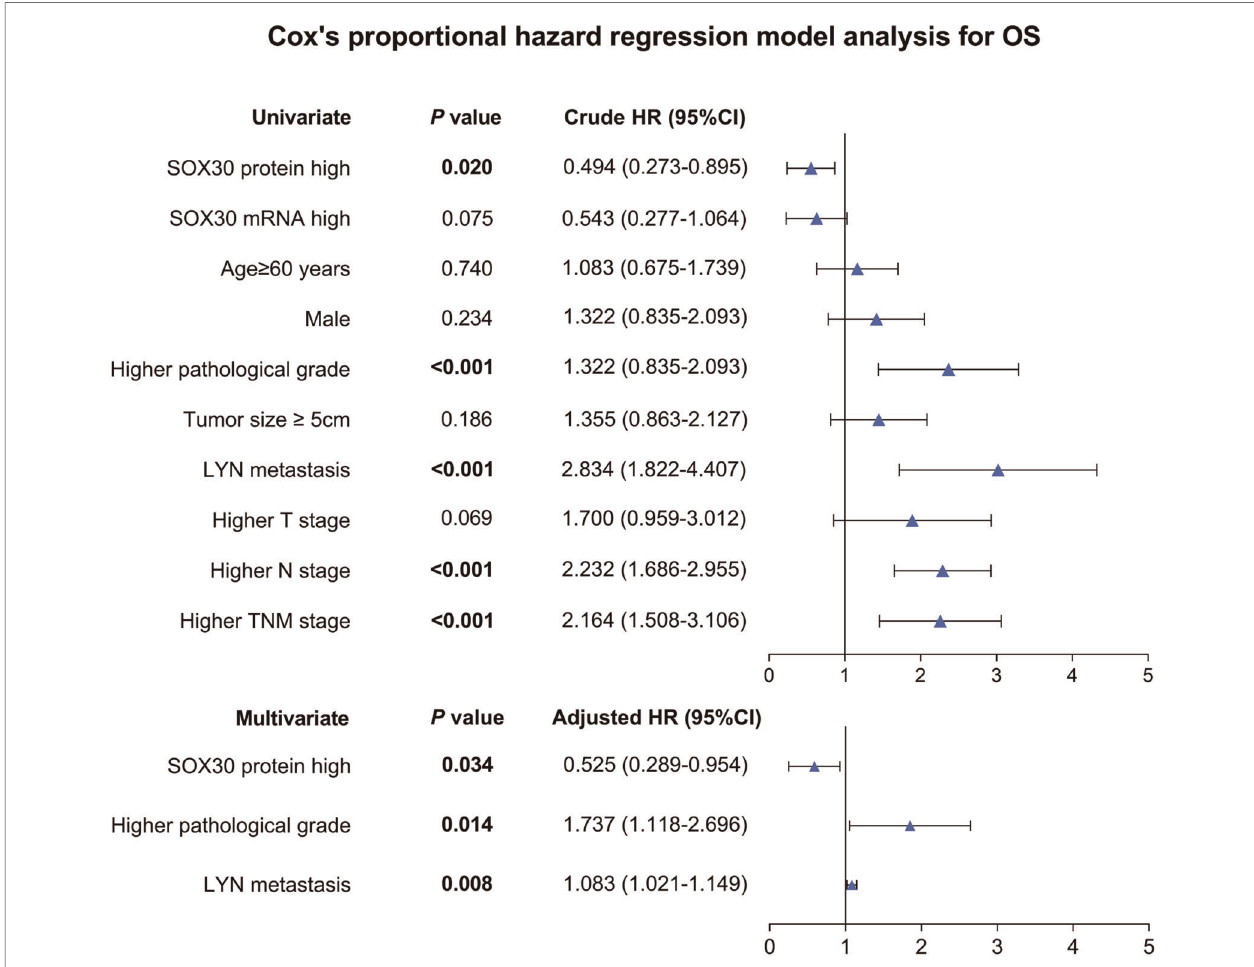
FIGURE 3 | Independent factors for OS. SOX30, sex-determining region Y-box containing gene 30; LYN, lymph node; TNM, tumor node metastasis; OS, overall survival; HR, hazard ratio; CI, con fi dence